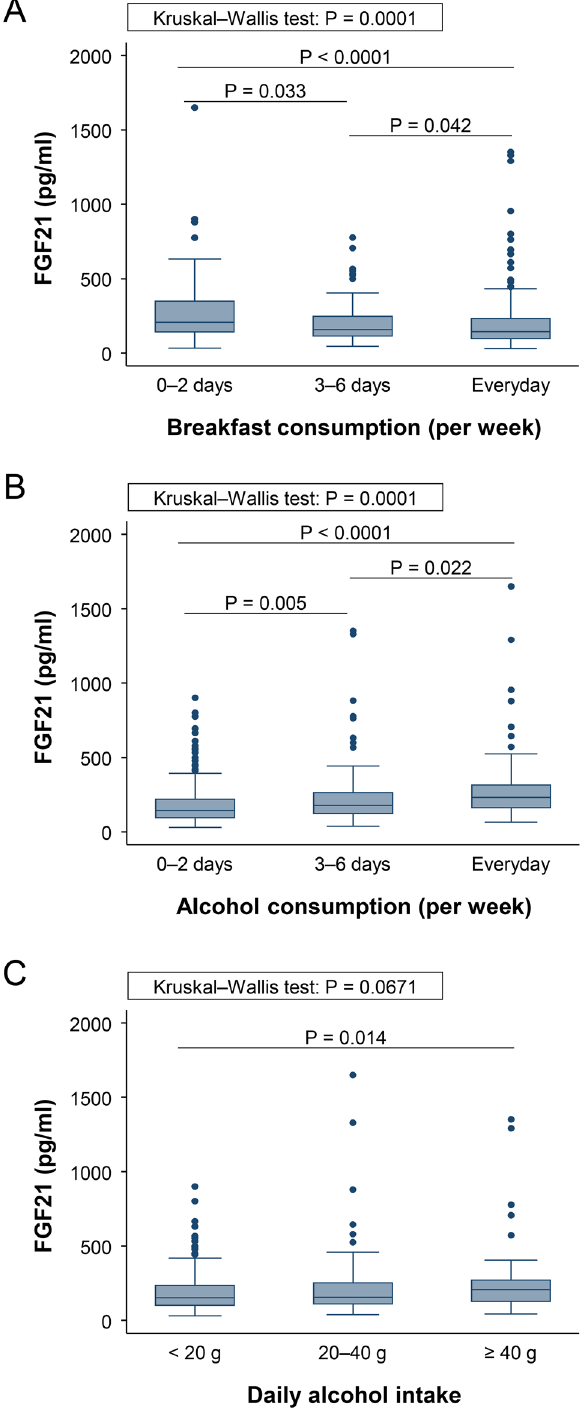
Figure 1. Serum levels of fibroblast growth factor (FGF) 21 are affected by breakfast and alcohol consumption. Associations of serum levels of FGF21 with ( A ) breakfast consumption frequency (0–2 days a week: n = 79, 3–6 days a week: n = 69, everyday: n = 240), ( B ) alcohol consumption frequency (0–2 days a week: n = 250, 3–6 days a week: n = 73, everyday: n = 75), and ( C ) daily alcohol intake (< 20 g: n = 170, 20–40 g: n = 78, ≥ 40